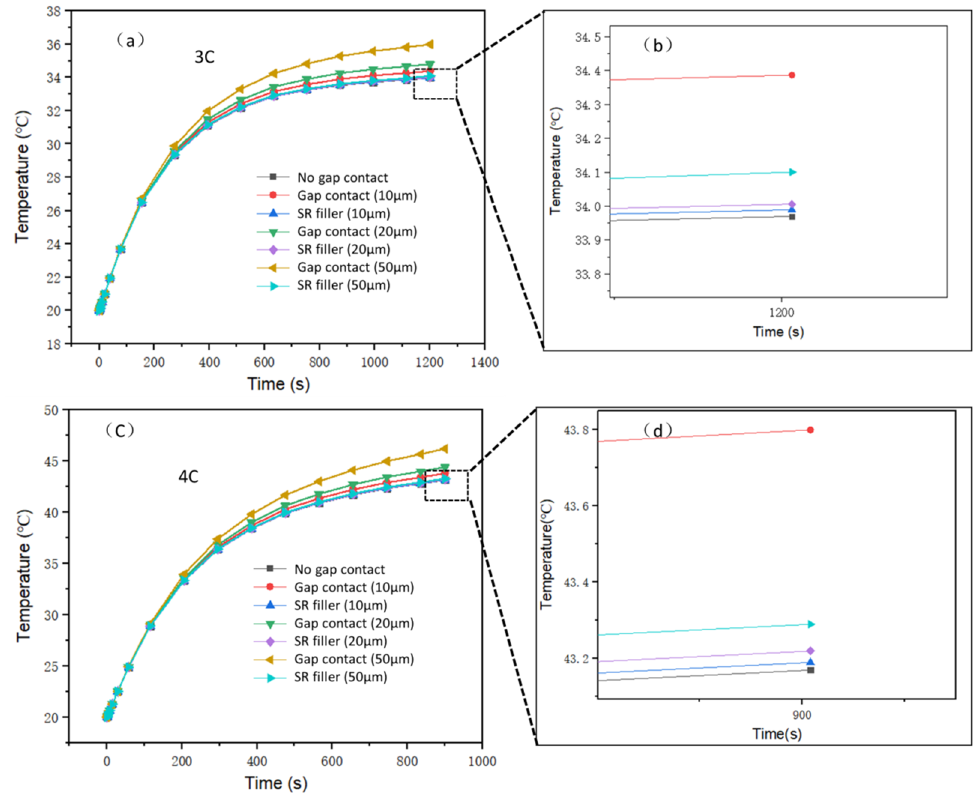
Figure 12. Maximum temperature curves of battery under different contact types: ( a ) 3C discharge; ( b ) 3C discharge local enlarged graph; ( c ) 4C discharge; ( d ) 4C discharge local enlarged graph.